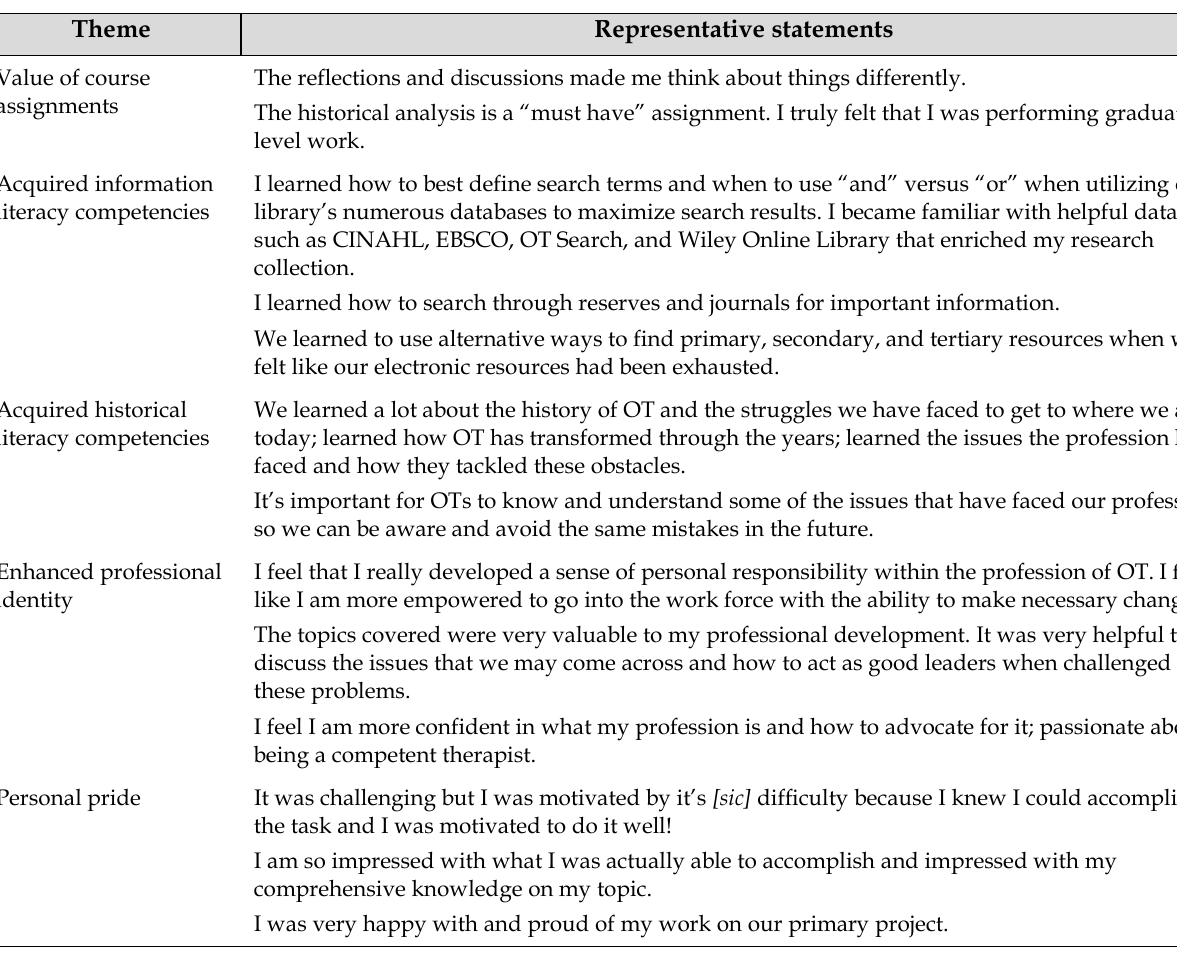
Table 2 Qualitative analysis of student course evaluation